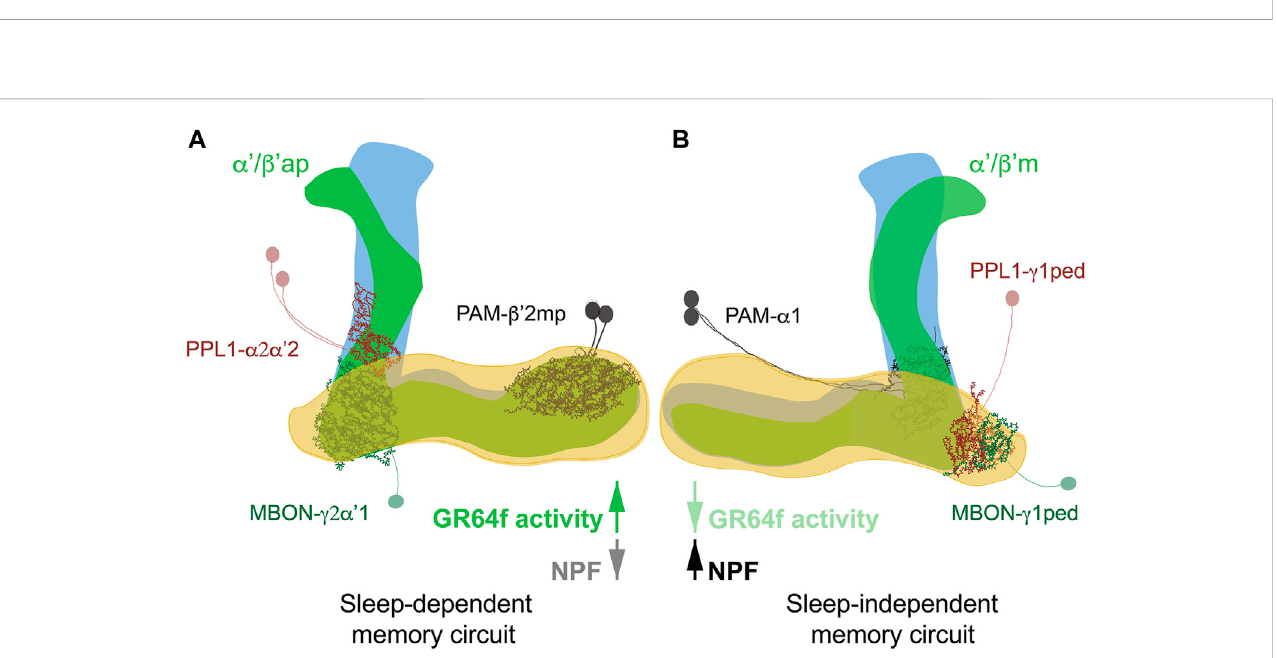
Sleep-dependent (A) and sleep-independent (B) circuits for appetitive memory. Fed fl ies form sleep-dependent memory that requires activity in α ′ / β ′ ap neurons in association with a circuit comprised of PAM- β ′ 2mp and recurrent connections between PPL1- γ 2 α ′ 1 DANs and MBON- γ 2 α ″ 1. In contrast, sleep- independent long-term memoryinstarved fl iesismediatedby α ′ / β ′ m neuronsinteractingwith PAM- α 1 andreciprocalsignalling between PPL1- γ 1pedc DANs and MBON- γ 1pedc. The switch between circuits is mediated by sweet taste signals received by gustatory receptor GR64f in fed fl ies and hunger signals mediated by NPF in starved fl